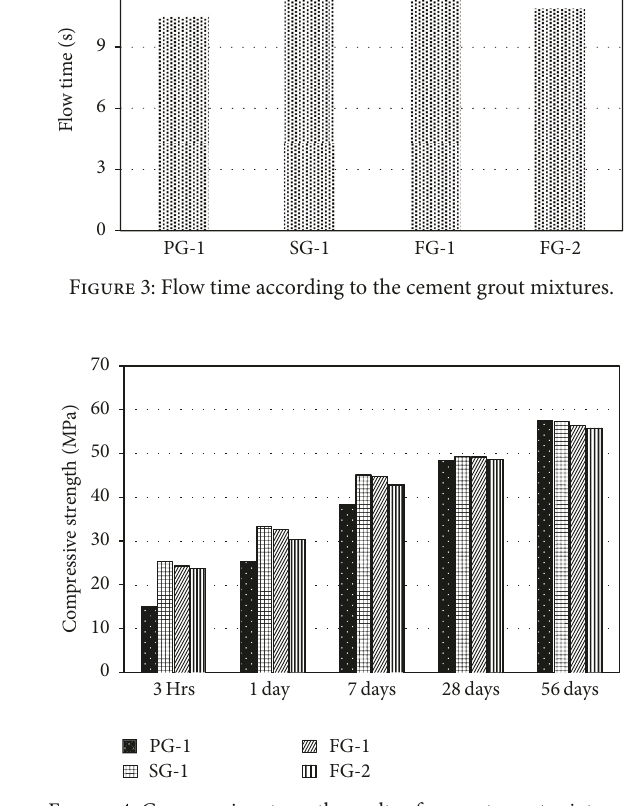
Figure 4: Compressive strength results of cement grout